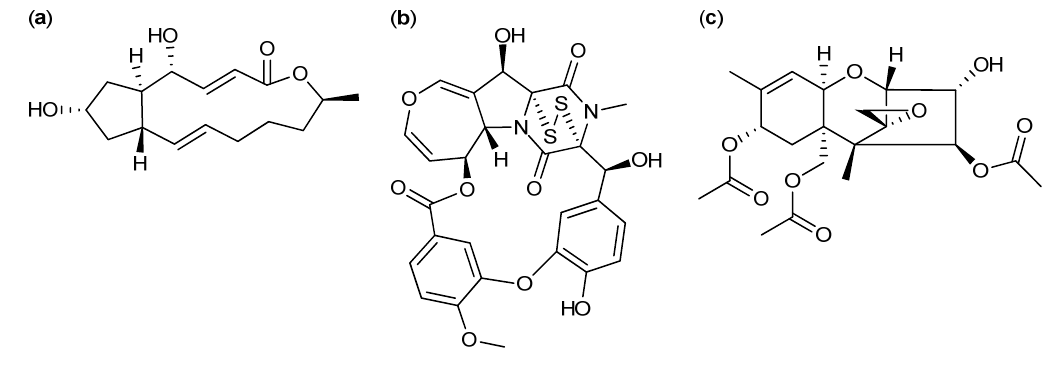
Figure 6. Examples of E-SPE and comparative dereplication ( a ) Brefeldin produced by P. cluniae , ( b ) Emestrin A produced by Aspergillus sp. ( Emericella -like state), and ( c ) Neosolaniol monoacetate produced by F. compactum